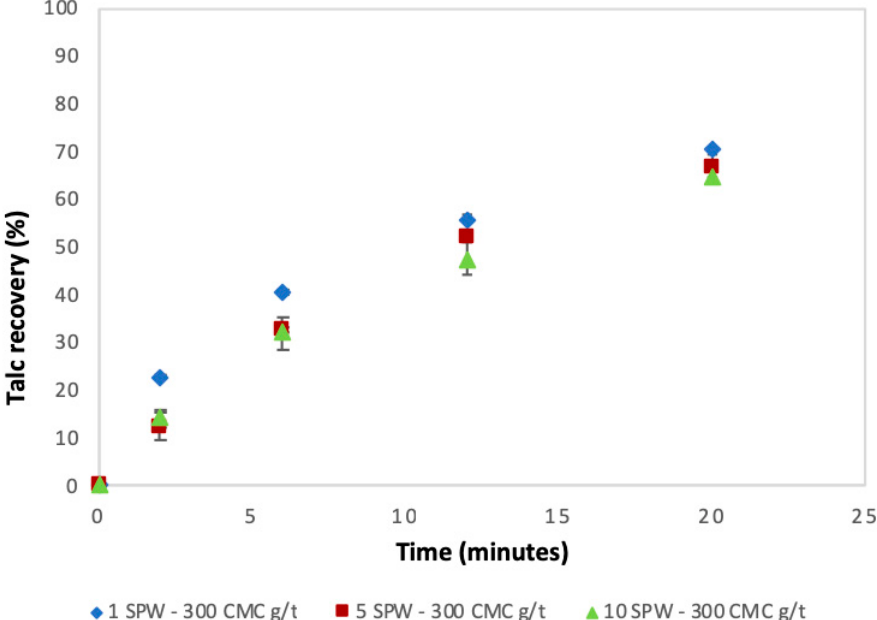
Figure 4. Talc recoveries as a function of time under increasing ionic strength in the presence of CMC at 300 g/t.